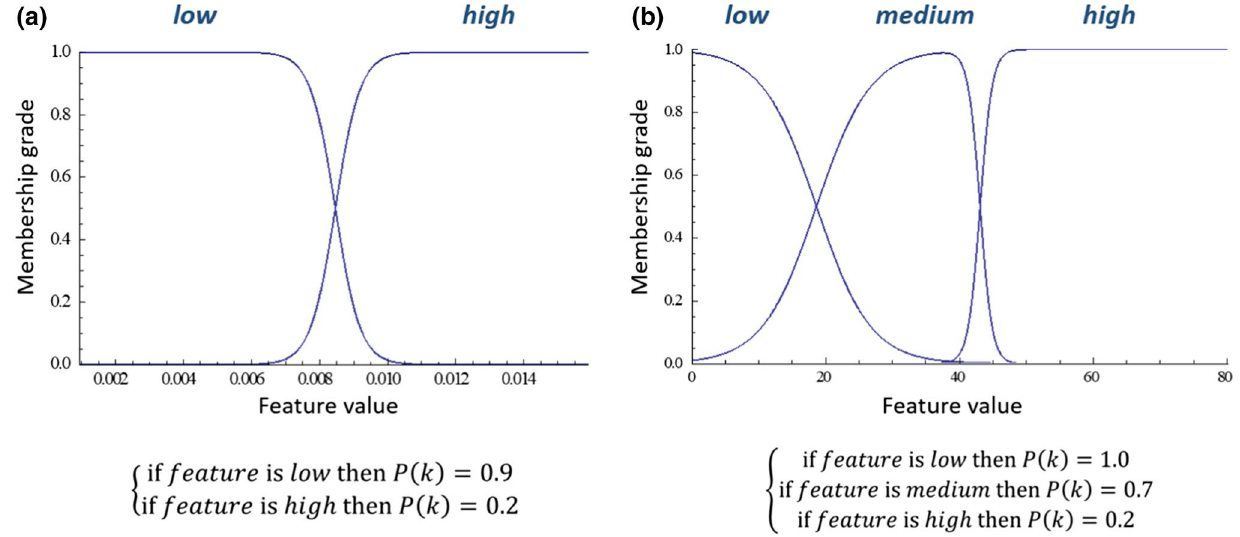
Fig. 2 Examples of fuzzy logic applied by defining two ( a ) and three ( b ) linguistic terms for a generic variable (feature) of the ML